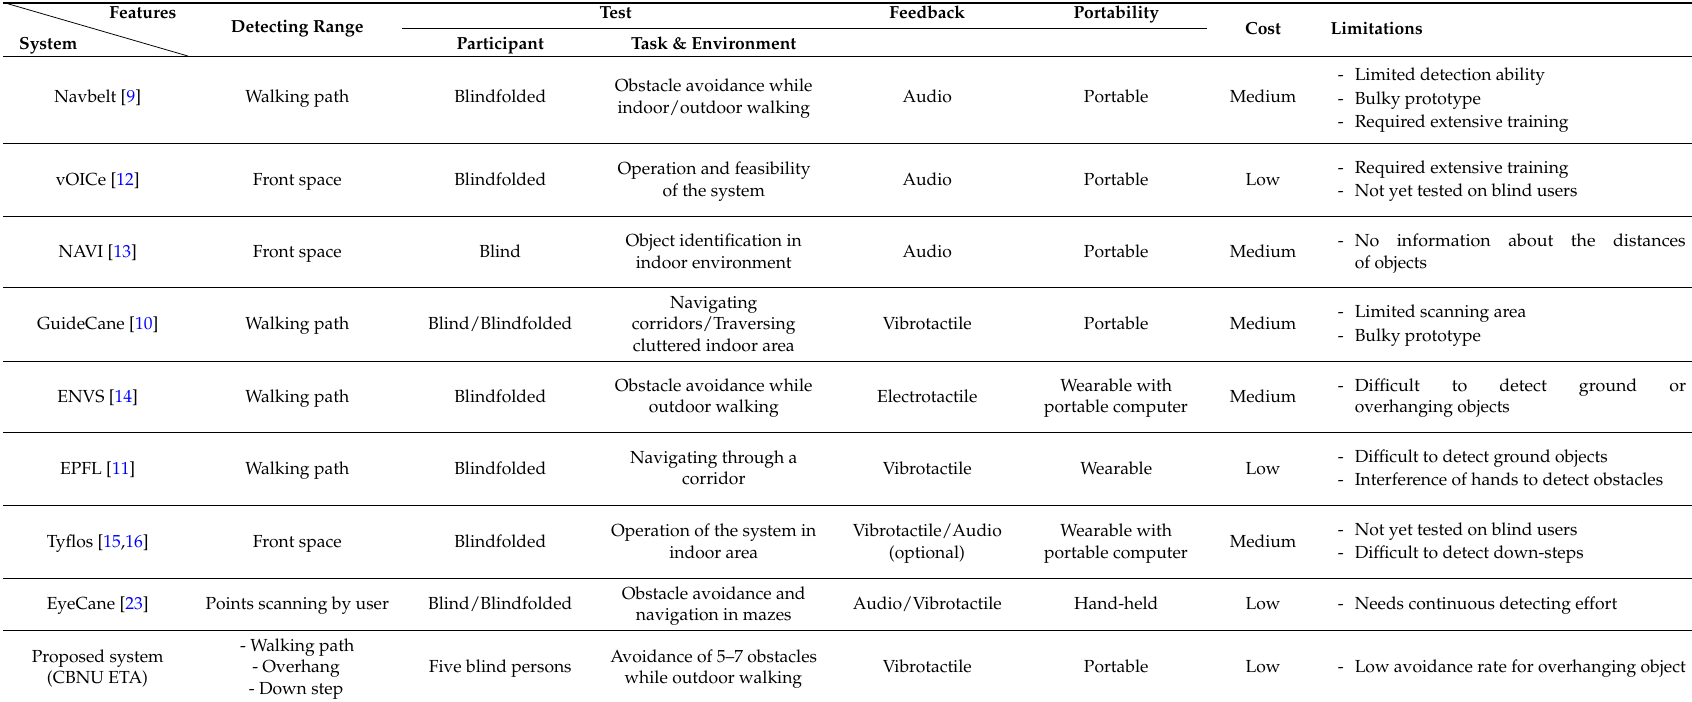
Table 9. Comparison of developed ETA for visually-impaired